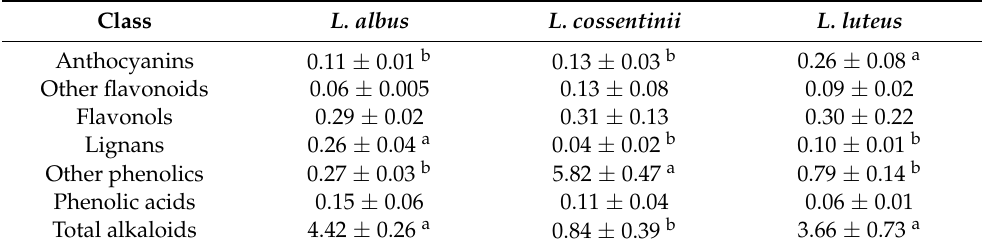
Table 1. Semi-quantification of the different phenolic classes and total alkaloids in the different Lupinus extracts.